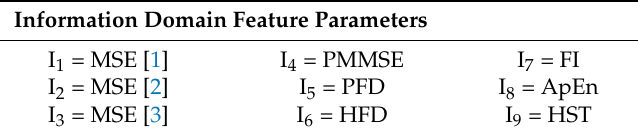
Table 3. Features in information